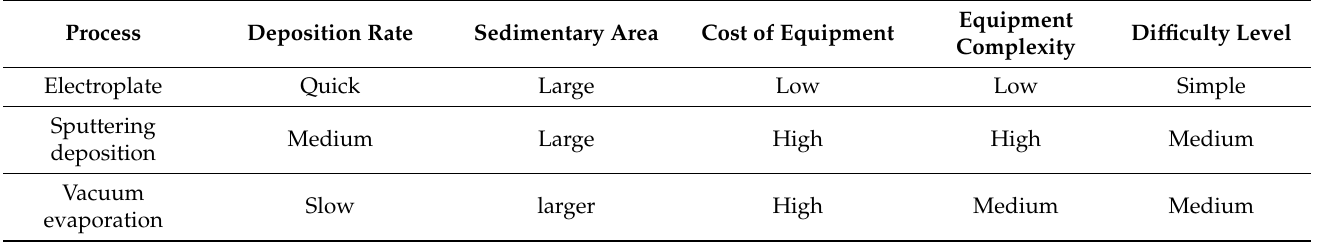
Table 5. Features of different processes for metal